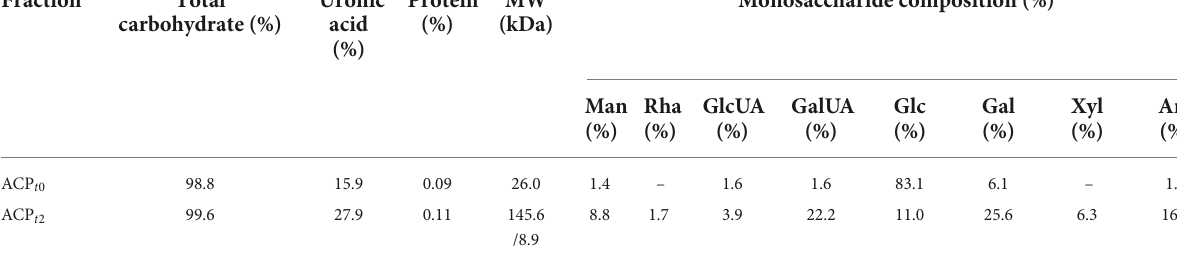
TABLE 2 The total sugar, uronic acid, and protein contents, and monosaccharide compositions molecular weight of the ACP t 0 and ACP t 2 . Fraction